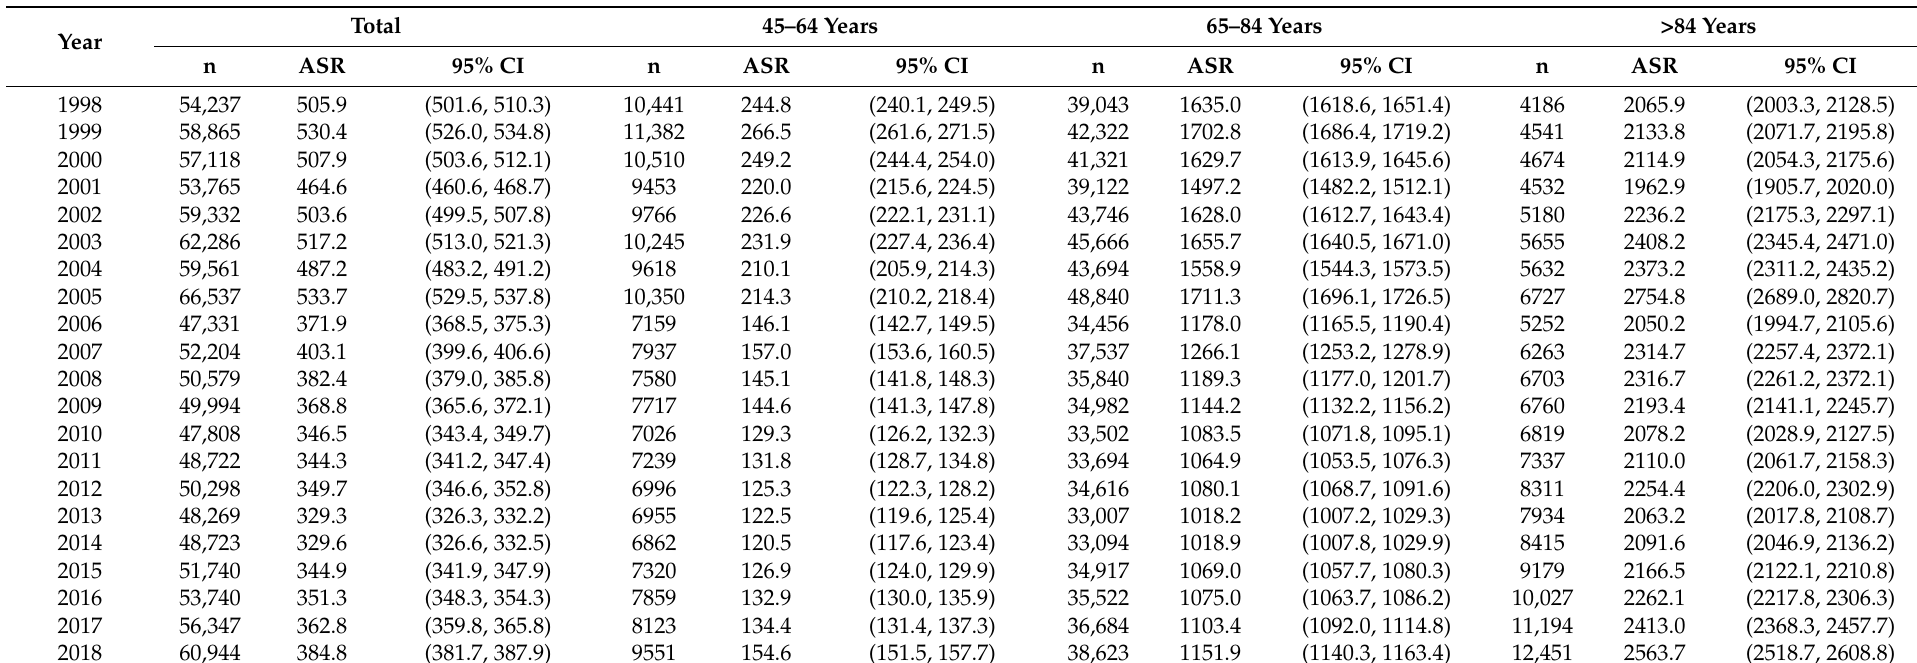
Table 3. Annual hospital admissions due to COPD and age-standardised rates (ASR) per 100,000 men/year in men, 1998 to